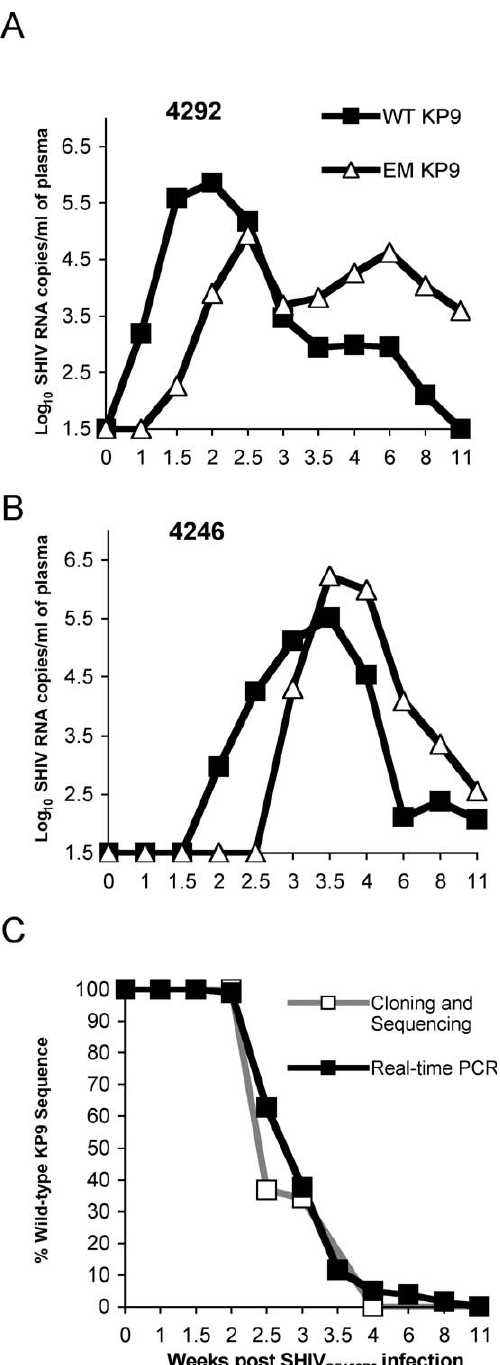
Figure 2. Minor Populations of Wild-Type KP9 Virus Can Be Detected by qRT-PCR during Chronic Infection SIV Gag KP9 qRT-PCR analysis was performed on serial RNA samples extracted from plasma from Mane-A*10 pigtail macaques (A) 4292 and (B) 4246 infected with SHIV SF162P3 . Wild-type and escape mutant KP9 viruses are represented by closed squares and open triangles, respectively, throughout. Cloning and sequencing (open squares) was compared to qRT-PCR (closed squares) to establish the proportions of wild-type KP9 virus in animal 4292 (C). A mean of 25 clones were sequenced across KP9 for each time